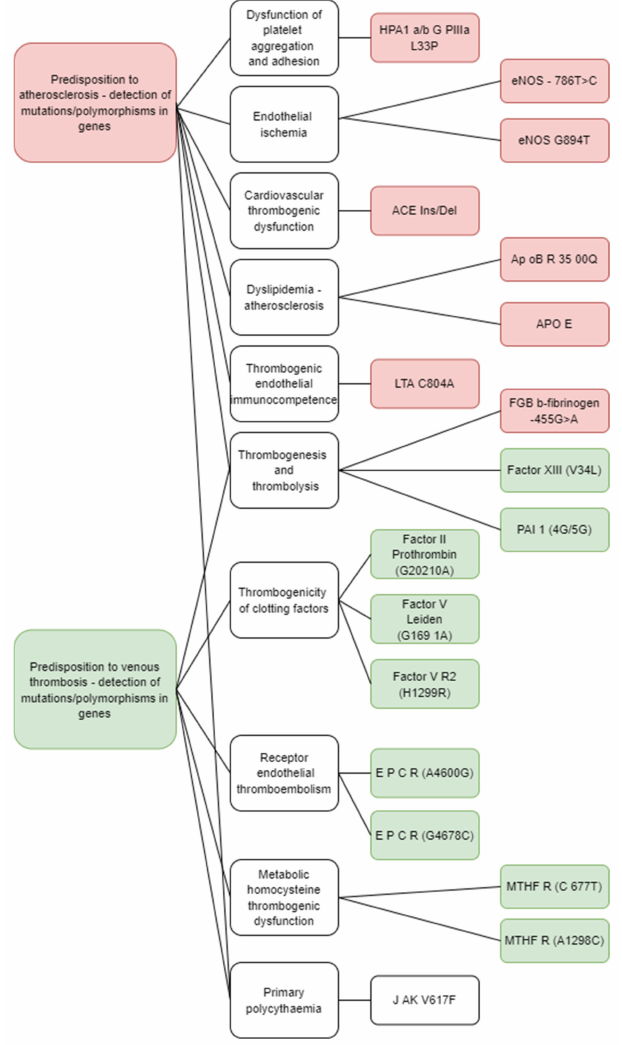
Figure 2. Investigated parameters within the whole